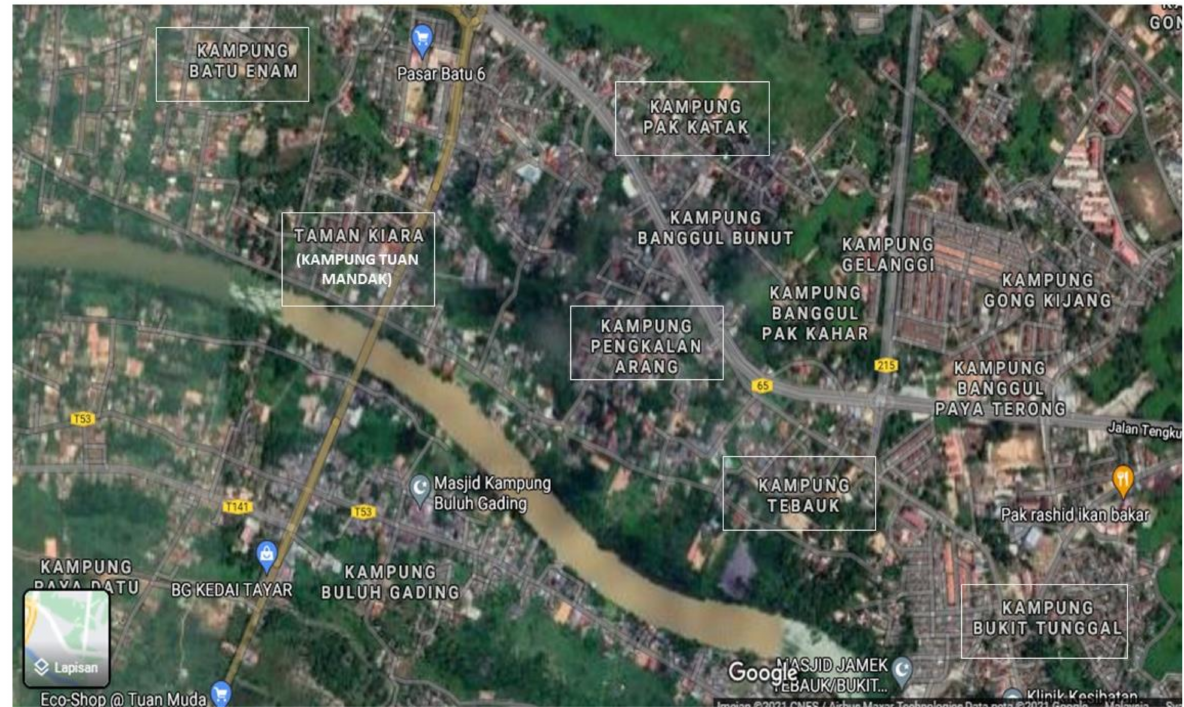
Figure 1. The location of six selected